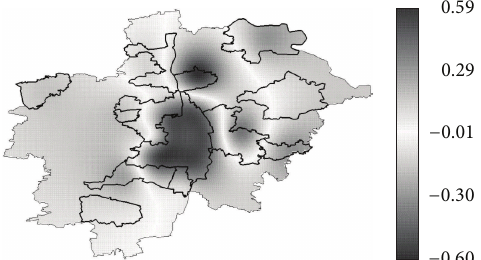
Figure 7: Difference between the interpolated surfaces of the observed and the predicted heterozygosity of the native subset ( 𝐻 𝑂 ( GER ) − 𝐻(𝑚 2 )